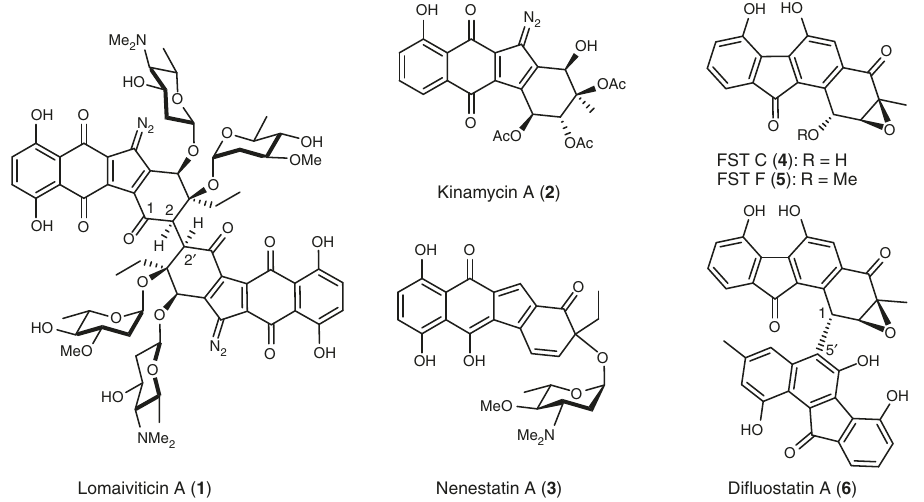
Fig. 1 Representatives of atypical angucyclines containing a benzo fl uorene